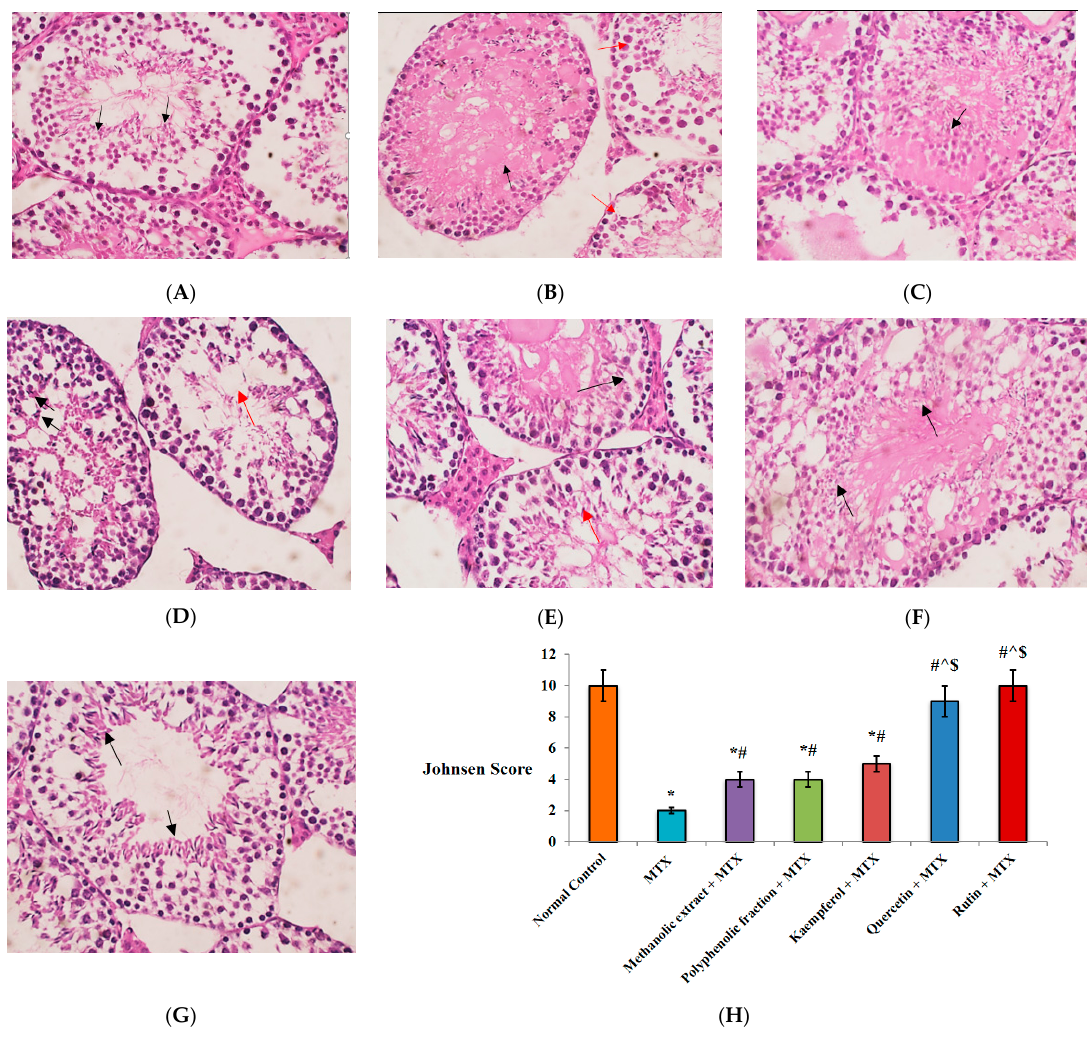
Figure 4. Photomicrographs of testicular sections from healthy and testicular injury-induced mice and effect of M. alysson L. methanolic extract, its polyphenolic fraction, isolated kaempferol, quercetin and rutin on Johnsen score in testicular-injury-induced mice. ( A ) Normal control group showing full spermatogenesis in all tubules, up to the level of spermatozoa (black arrows). ( B ) MTX group showing some hyalinized tubules (40%) (black arrow), with other tubules showing significant reduction in spermatogenesis, with few spermatocytes (red arrows). ( C ) Methanolic extract + MTX group showing hyalinized tubules with markedly disturbed spermatogenesis, with detected spermatocytes only. ( D ) Polyphenolic fraction + MTX group showing full spermatogenesis in some tubules (60%), but with few spermatozoa (black arrows), other tubules show marked decreased spermatogenesis (red arrows). ( E ) Kaempferol + MTX group showing absent germinal cells in some tubules (30%), with hyalinized lumen and with only Sertoli cells (black arrow), while other tubules show spermatogenesis, to the level of early spermatids (red arrows). ( F ) Quercetin + MTX group demonstrated complete spermatogenesis in all tubules, reaching the level of spermatids (black arrows), despite the disturbed lining epithelium and the hyalinized tubal lumens. ( G ) Rutin + MTX group showing full spermatogenesis in all tubules, up to level of spermatids (black arrows) (H&E, 40 × ). ( H ) Johnsen Score. Data are presented as mean ± SD, (n = 8). * Significant versus normal control. # Significant versus MTX. ˆ Significant versus methanolic extract. $ Significant versus polyphenolic fraction. p value ≤